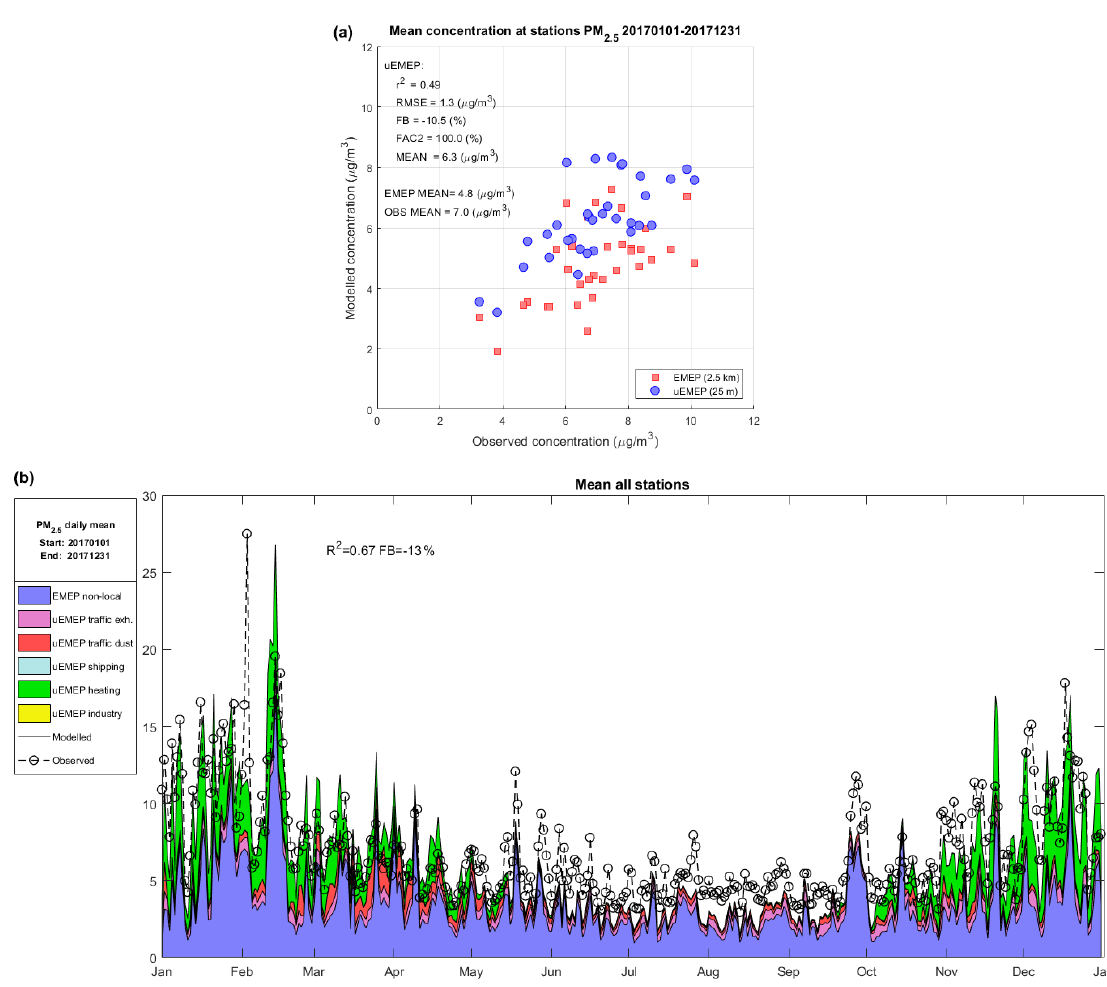
Figure 11. (a) Scatter plot comparison of modelled and observed PM 2 . 5 for annual average concentrations at each station. Shown are the results for both uEMEP and EMEP. Comparative statistics are shown for the uEMEP calculation. EMEP and observed means are also included. (b) Source contributions are shown from both uEMEP and EMEP models for the temporal modelling results along with the EMEP 2.5km calculation (EMEP4NO). A total of 33 stations are used in the